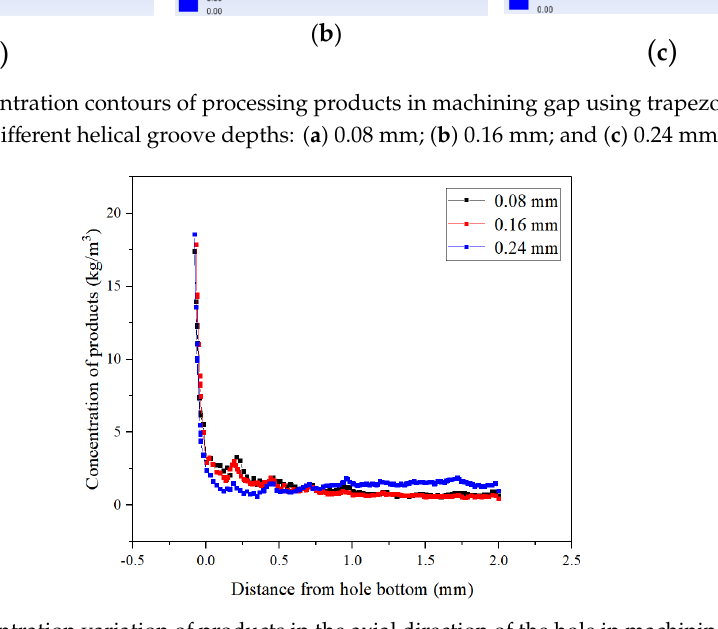
Figure 13. Concentration variation of products in the axial direction of the hole in machining gap using trapezoidal helices with different helical groove depths.